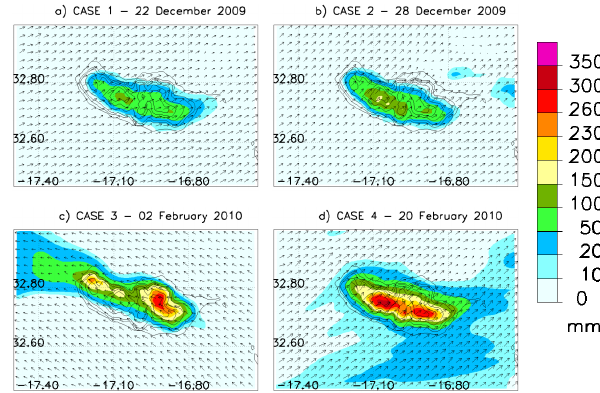
Figure 8. The shaded areas represent the daily accumulated precipitation (mm) simulated with 2 Fig. 8. The shaded areas represent the daily accumulated precipita- the MESO-NH Model, solid lines the Madeira orography (m) obtained from the GTOPO30 3 tion (mm) simulated with the MESO-NH model, solid lines rep- database and horizontal wind vectors at model level 18, approximately 1 km above the 4 resent the Madeira orography (m) obtained from the GTOPO30 surface (a) 22 December 2009 and wind vectors at 20 UTC, (b) 28 December 2009 and wind 5 database, and arrows represent the horizontal wind vectors at model vectors at 05 UTC, (c) 02 February 2010 and wind vectors at 07 UTC, and (d) 20 February 6 level 18, approximately 1km above the surface: (a) 22 Decem- 2010 and wind vectors at 12 UTC. 7 ber 2009 and wind vectors at 20:00UTC, (b) 28 December 2009 and wind vectors at 05:00UTC, (c) 2 February 2010 and wind vec- tors at 07:00UTC, and (d) 20 February 2010 and wind vectors at